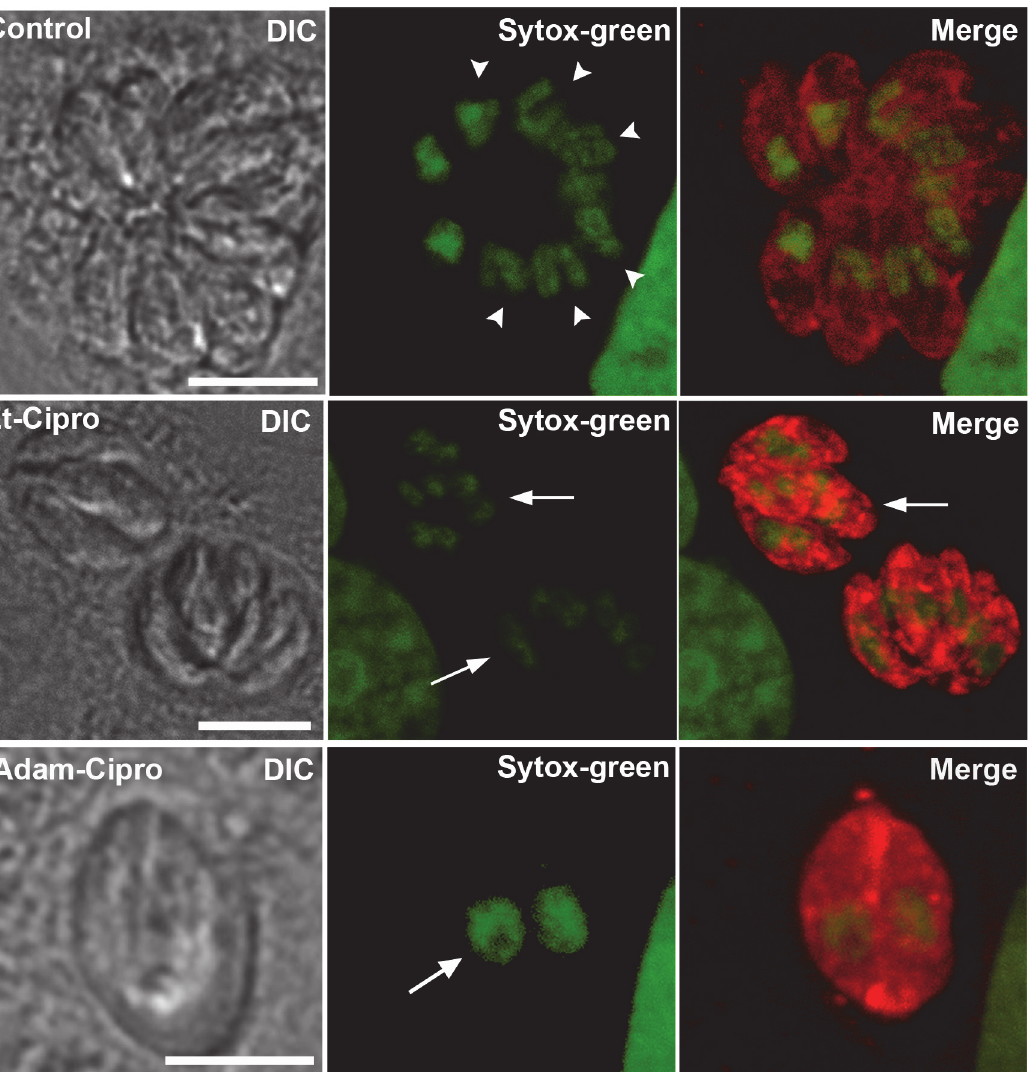
Fig 3. Cipro derivatives did not affect parasite mitosis. Parasites were labeled with anti-SAG1 (red, labeling the parasite ’ s cell surface) and Sytox green (to label the DNA). After 24 h of infection, untreated (control) parasites (top row) were typically arranged in ‘ rosettes ’ , and displayed normal morphology, with one nucleus per cell. Many parasites were in the process of cell division, as evidenced by the presence of U-shaped mitotic nuclei (arrowheads). In cells treated with 5 μ M of Et-Cipro (middle row) or Adam-Cipro (bottom row) for 24 h, tachyzoites were able to complete nuclear division, as evidenced by the presence of individualized nuclei, but could not complete cytokinesis, which led to the formation of multinucleated cells (arrows), and loss of the typical rosette organization. Images represent maximum projections of optical slices from confocal laser scanning